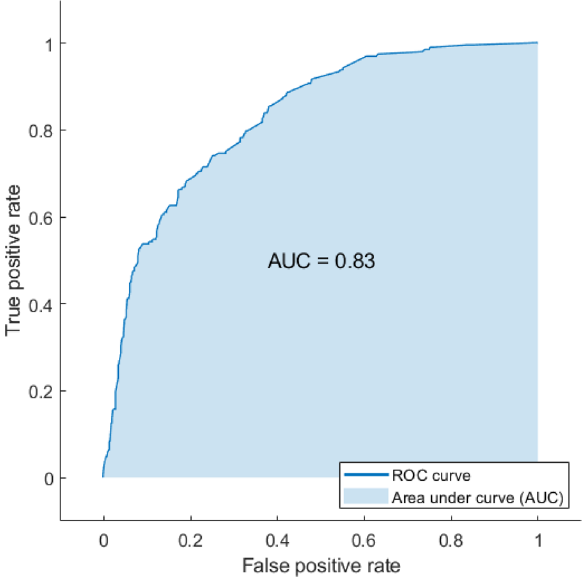
Figure 3. ROC curve of the subspace of ensemble machine learning bagged trees model for detecting visual field damage (normal versus abnormal) from corneal